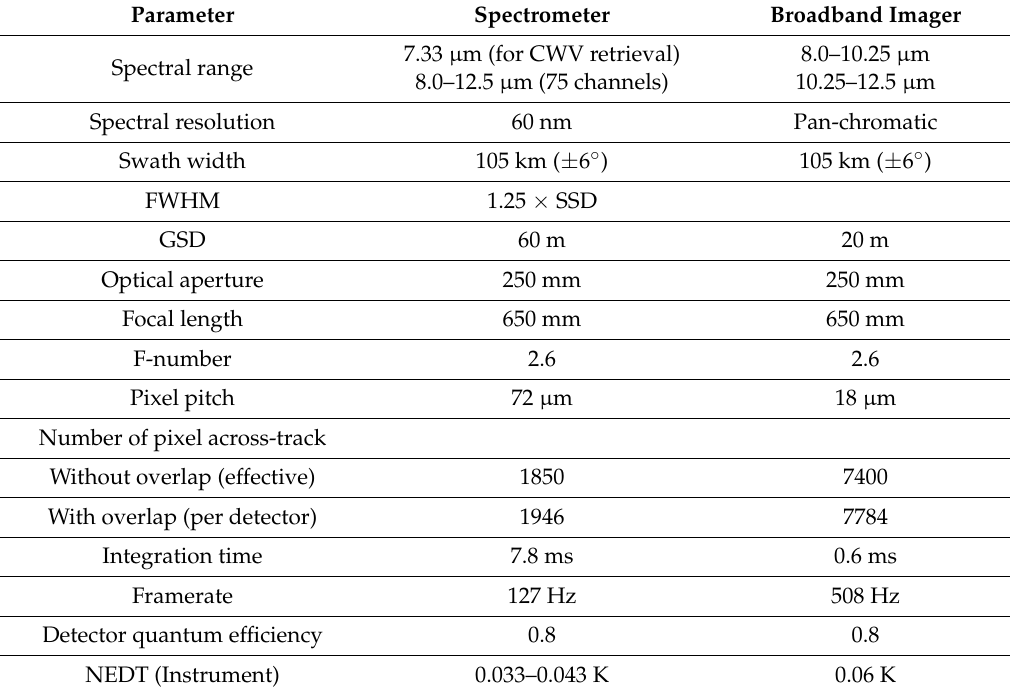
Table 4. HiTeSEM Instrument